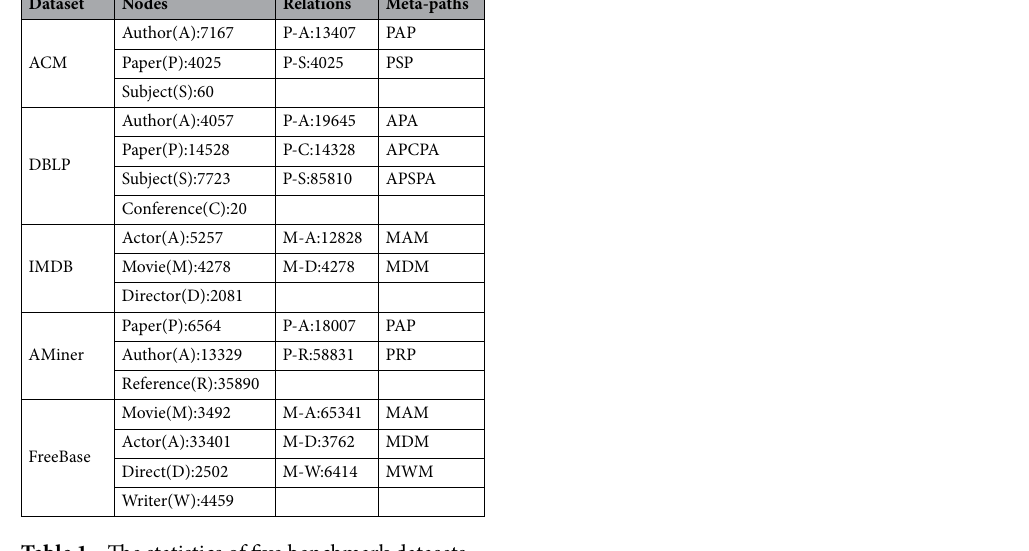
Table 1. The statistics of five benchmark datasets.